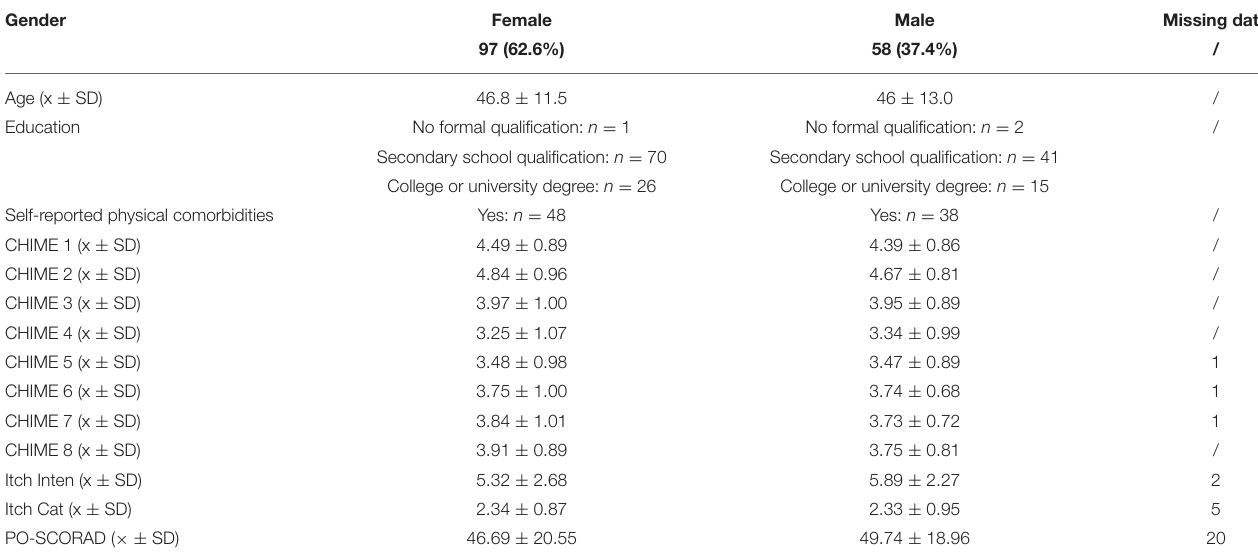
TABLE 1 | Description of the sample ( n = 155 patients with atopic dermatitis).